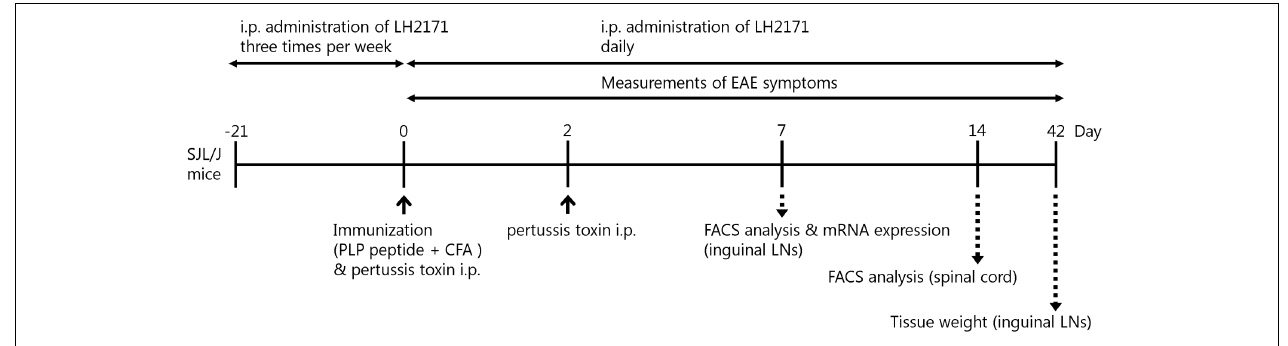
FIGURE 1 | Experimental schedule. Female SJL/J mice (5 weeks old) were immunized by intradermal injection with 100 µ g of PLP139–151 (HSLGKWLGHPDKF) emulsified with CFA, in addition to two intraperitoneal injections of 400 ng of pertussis toxin on days 0 and 2. For assessment of LH2171, the mice were injected with 100 µ L of PBS containing 1 mg of LH2171 intraperitoneally three times a week from 3 weeks before immunization and then daily after the immunization.